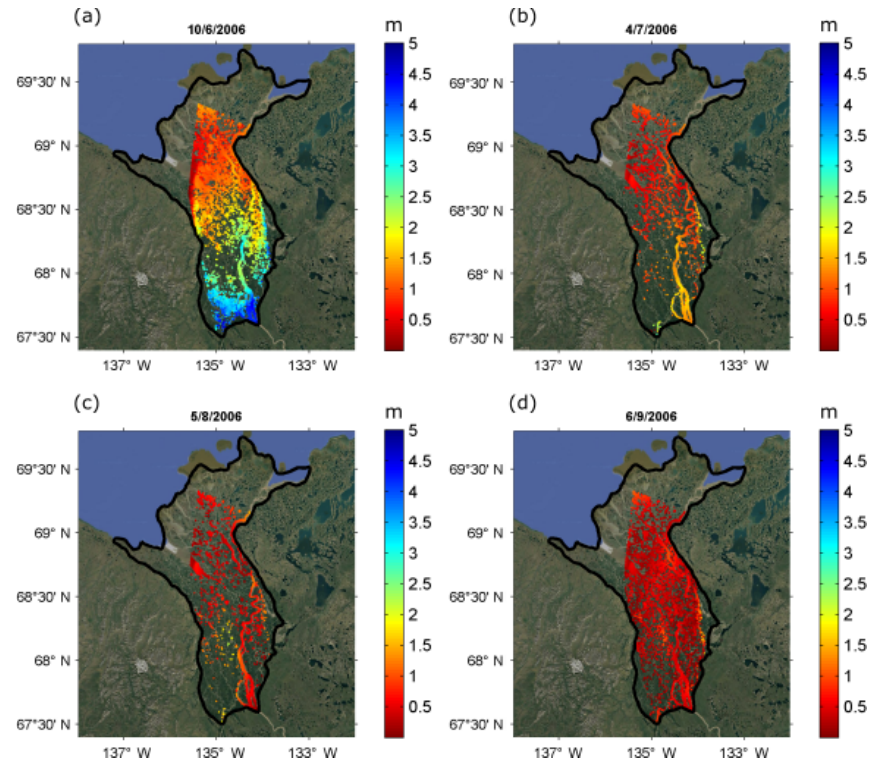
Figure 9. Water level maps in the Mackenzie Delta in 2006 (historic flood) obtained by combining inundated surfaces determined using MODIS images with altimetry-derived water levels (a) in June, (b) in July, (c) in August and (d) in September.